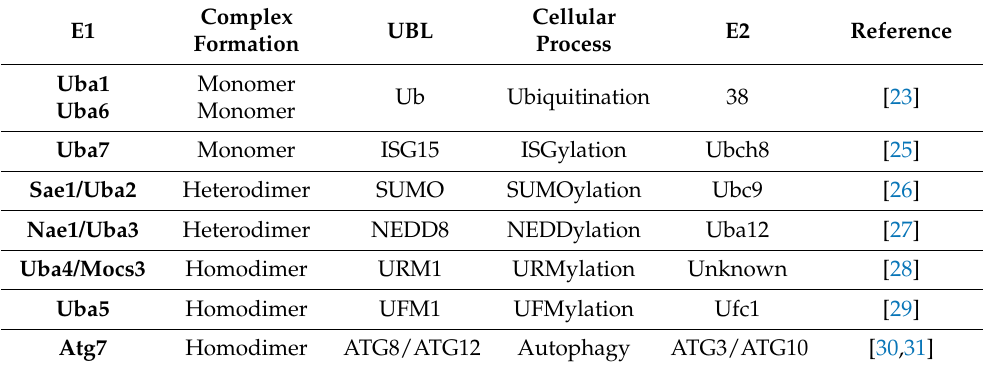
Table 1. Summary of E1 and E2 enzymes for ubiquitin-like